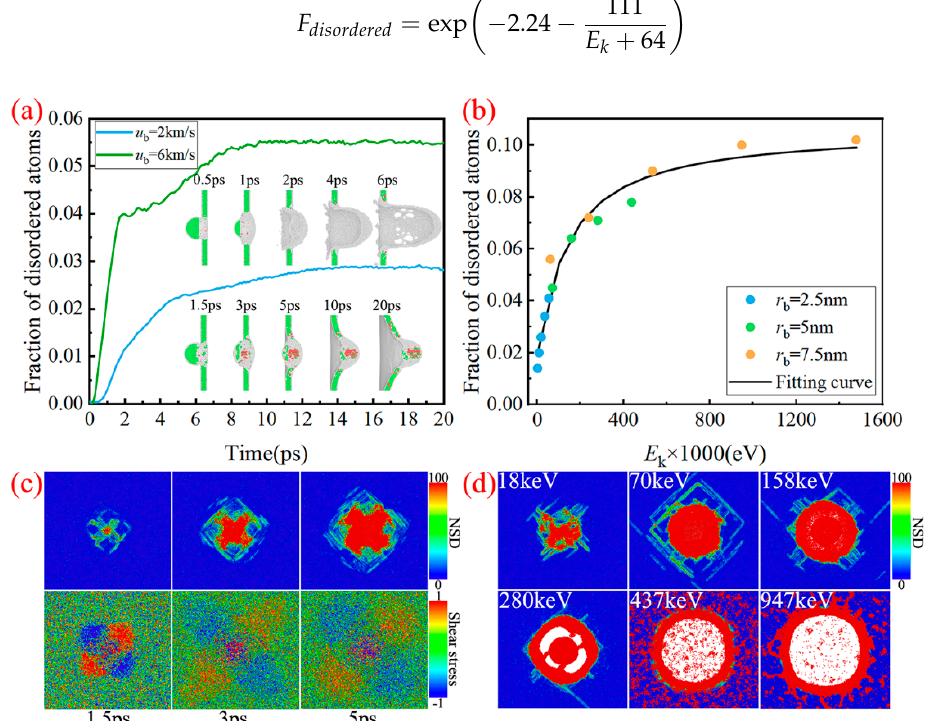
Figure 6. ( a ) The number of disordered atoms and the corresponding microstructure evolution. ( b ) Fraction of the disordered atoms in final state versus incident kinetic energy. ( c ) Evolution of nonaffine squared displacement (NSD) and shear stress with time ( u b = 2 km/s). ( d ) Nonaffine squared displacement caused by different initial kinetic energy. Atoms are color-coded by their local lattice structure [FCC (green), HCP (red) and disordered (white)] as obtained from dislocation extraction algorithm (DXA).